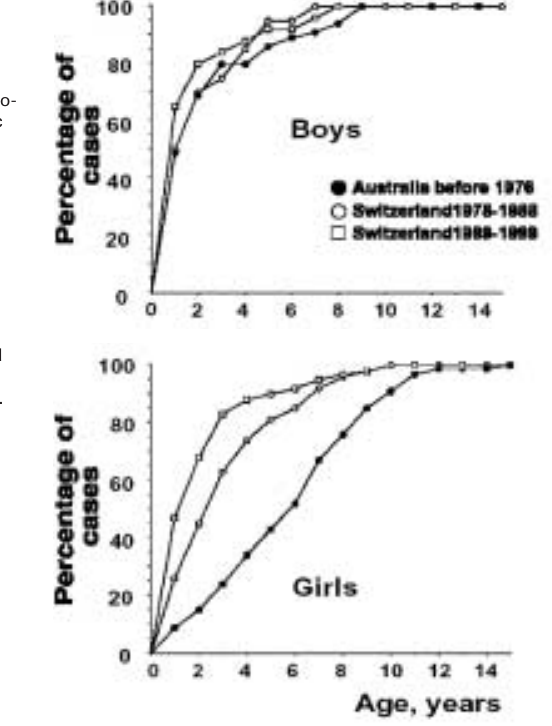
Cumulative fre- quency distribution polygon for the age at the time of diagno- sis of vesicoureteric reflux in children with urinary tract infections. Swiss children with reflux detected between 1978 and 1988 and between 1989 and 1999 as well as Australian children (redrawn from [3]) with reflux detected before 1976 are depicted separately.